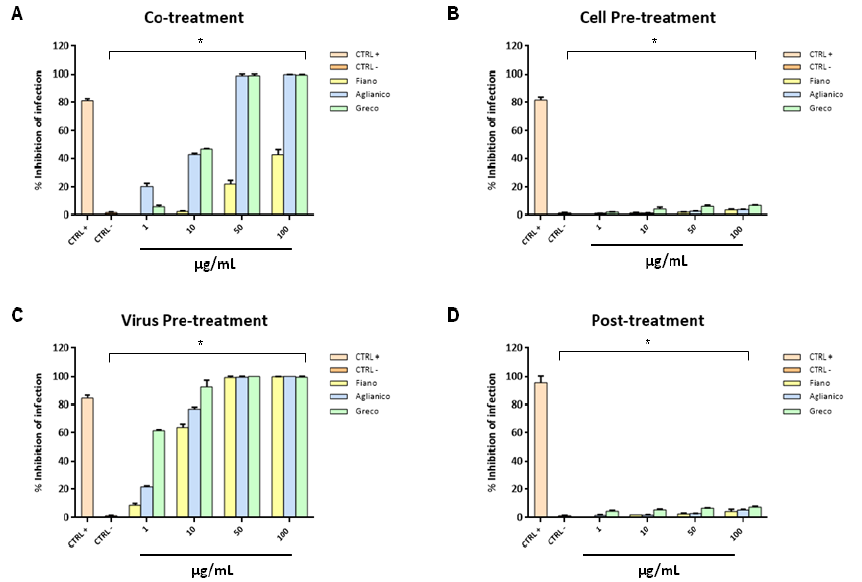
Figure 6. Antiviral activity against HSV-1 of extracts at pH 7.00. Different assays were performed in order to evaluate anti-HSV-1 activity. Extracts inhibited the early stages of infection, acting in co-treatment ( A ) and virus pre-treatment ( C ) assays. Extracts were not able to interact with the cellular surface ( B ) or block the viral replication ( D ). Statistical differ- ences were evaluated via two-way ANOVA; a value of p ≤ 0.05 was considered significant, with * p ≤